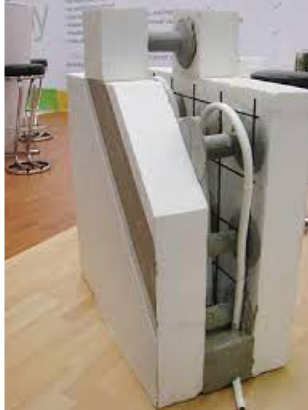
Figure 1. Lost formwork for reinforced concrete building envelope ISOMAX